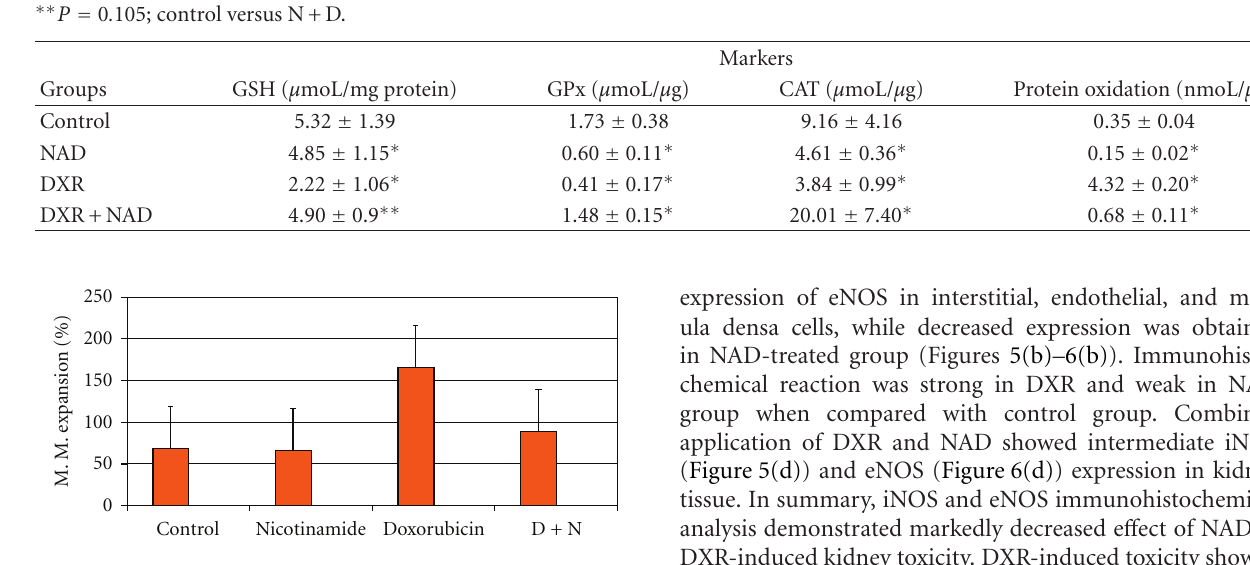
Figure 3: Mesangial matrix expansion % tissue in the kidney